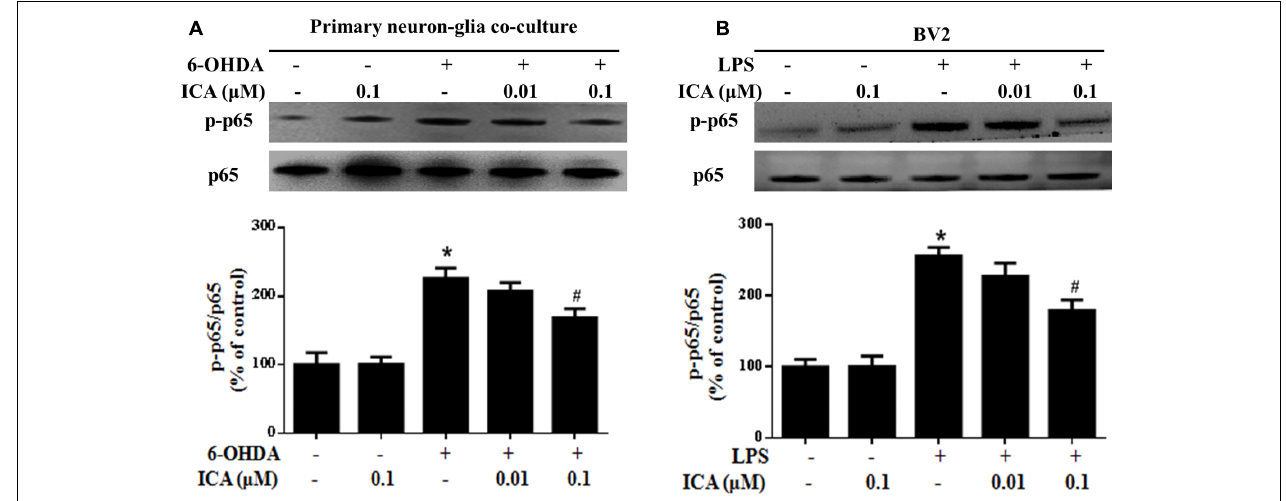
FIGURE 6 | Icariin attenuated LPS-/6-OHDA-induced NF- κ B signaling pathway activation in vitro . Primary neuron-glia cultures (A) and BV2 cell line (B) were treated with ICA for 30 min and then stimulated with 6-OHDA or LPS for 24 h. The protein expressions of phosphorylated p65 (p-p65) and p65 were investigated by western blot analysis. The ratio of densitometry values of p-p65 with total p65 was analyzed and normalized to each respective control group. Results were the mean ± SEM from three independent experiments performed in triplicate. ∗ p < 0.05 compared with the control cultures; # p < 0.05 compared with 6-OHDA/LPS-treated cultures.